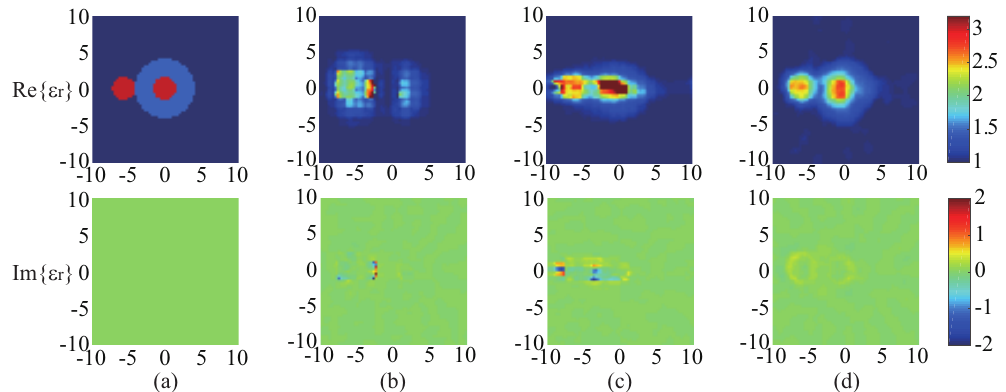
Figure 8. ( a ) Exact profile “ FoamTwinDiel ”; ( b – d ) Reconstructed results against FoamTwinDiel data set at 9 GHz, corresponding to three rounds of optimization, respectively. The real ( first row ) and imaginary ( second row ) of the reconstructed results. The 1st, 2nd, and 3rd rounds of optimization correspond to β being 6, 3, and 0.5, coupled with M w being 256, 512, and 768,